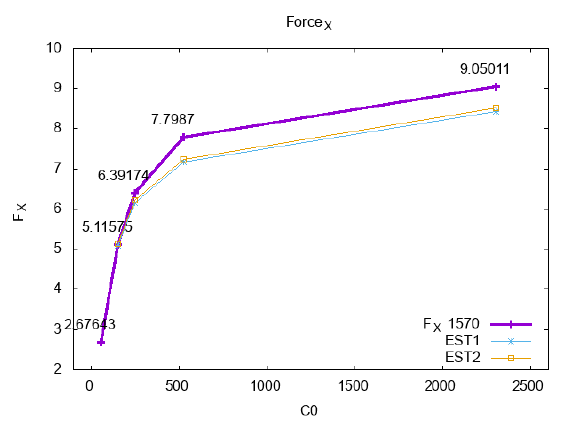
Fig. 4. Regime 1570, the force acting on the barriers with poros- ity 50%, 42%,30%,15%, CFD simulations and simplified estima- tions based on the relation (15) and table 1.